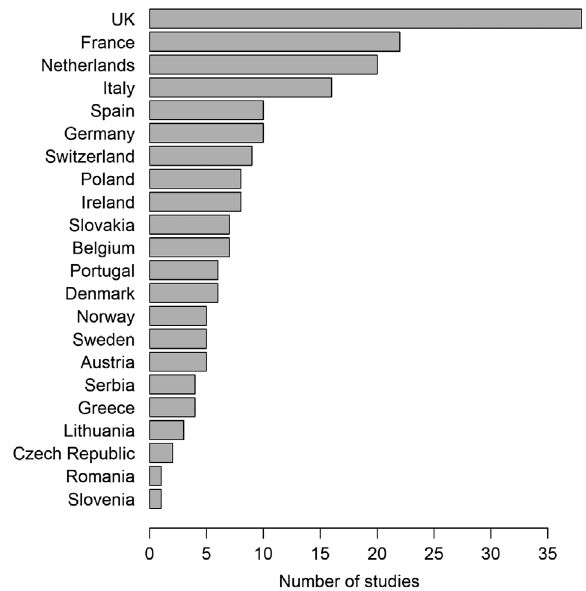
Figure 1. Number of publications investigating anthelmintic resis- tance in gastro-intestinal nematodes reported from each country and included in the